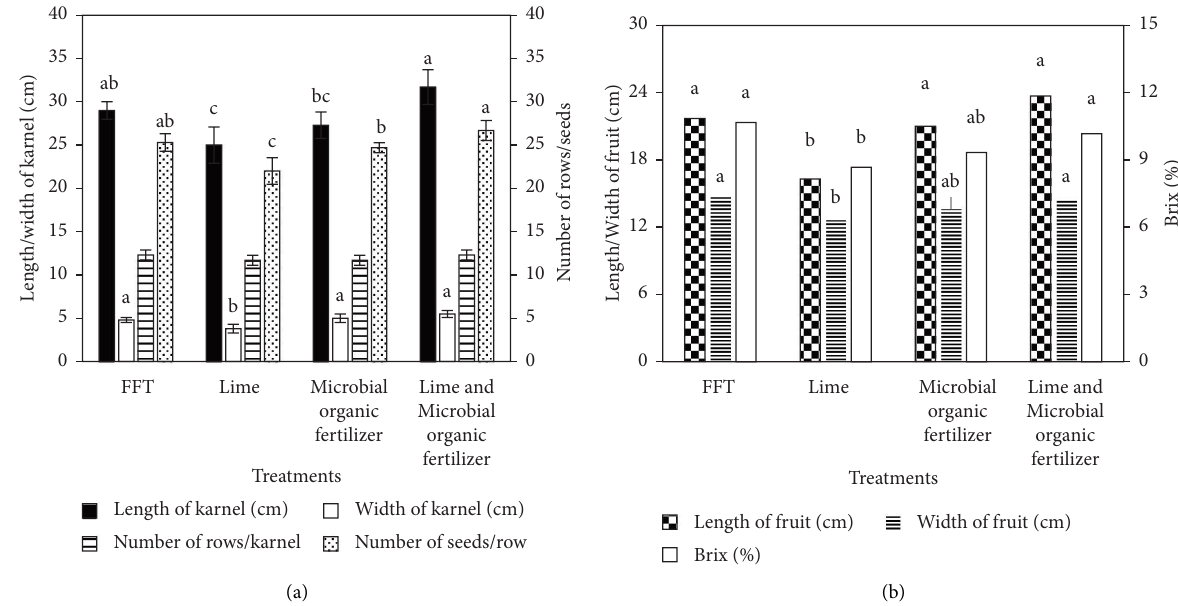
Figure 4: Length and width of kernel, number of row/kernel, and number of seeds/kernel of glutinous corn (a); length, width, and Brix index of fruit of watermelon